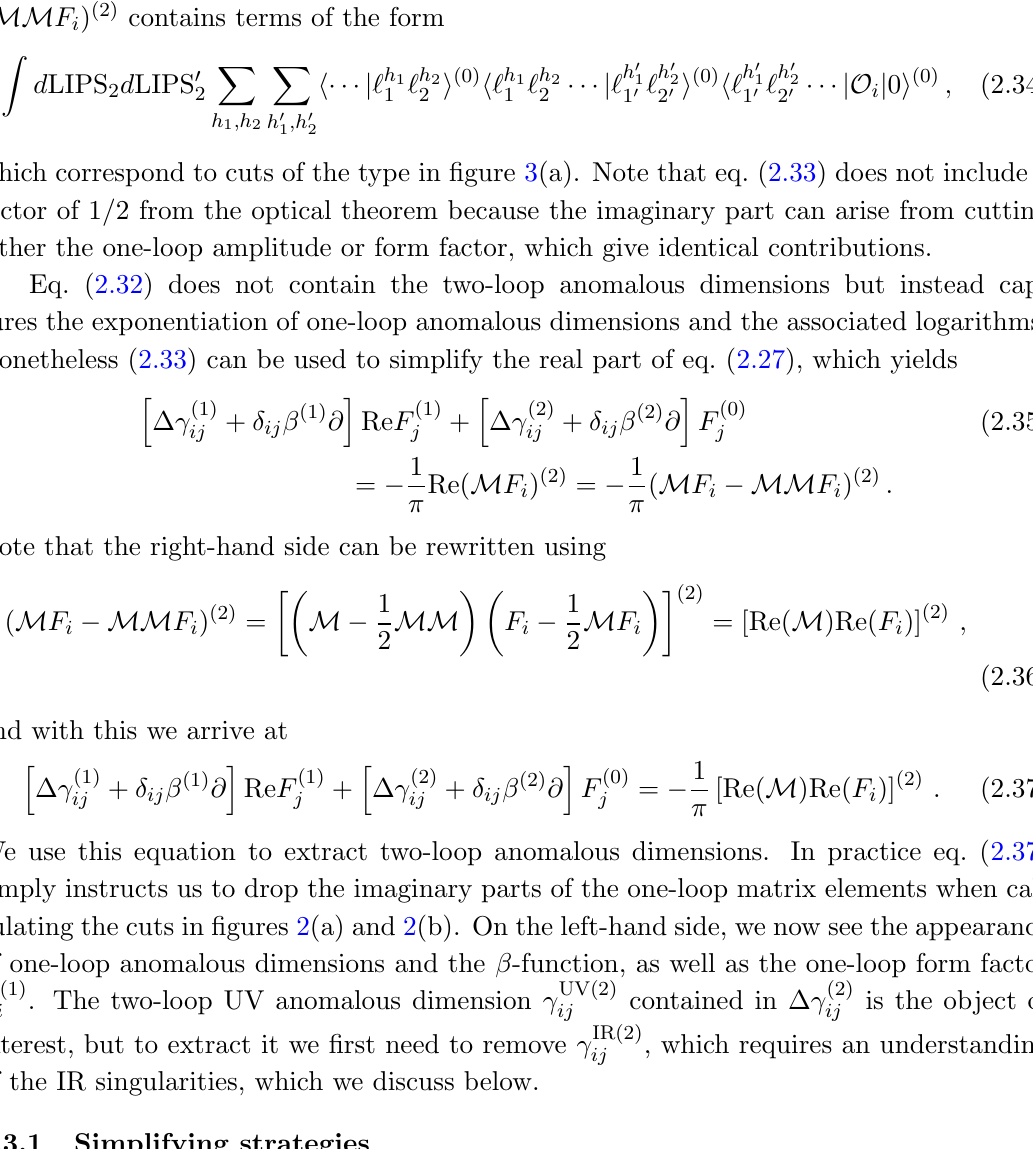
Figure 3 . Iterated two-particle cuts that appear on the right-hand side of eq. (2.33). where the relevant cuts are the iterated two-particle cuts in (cid:12)gure